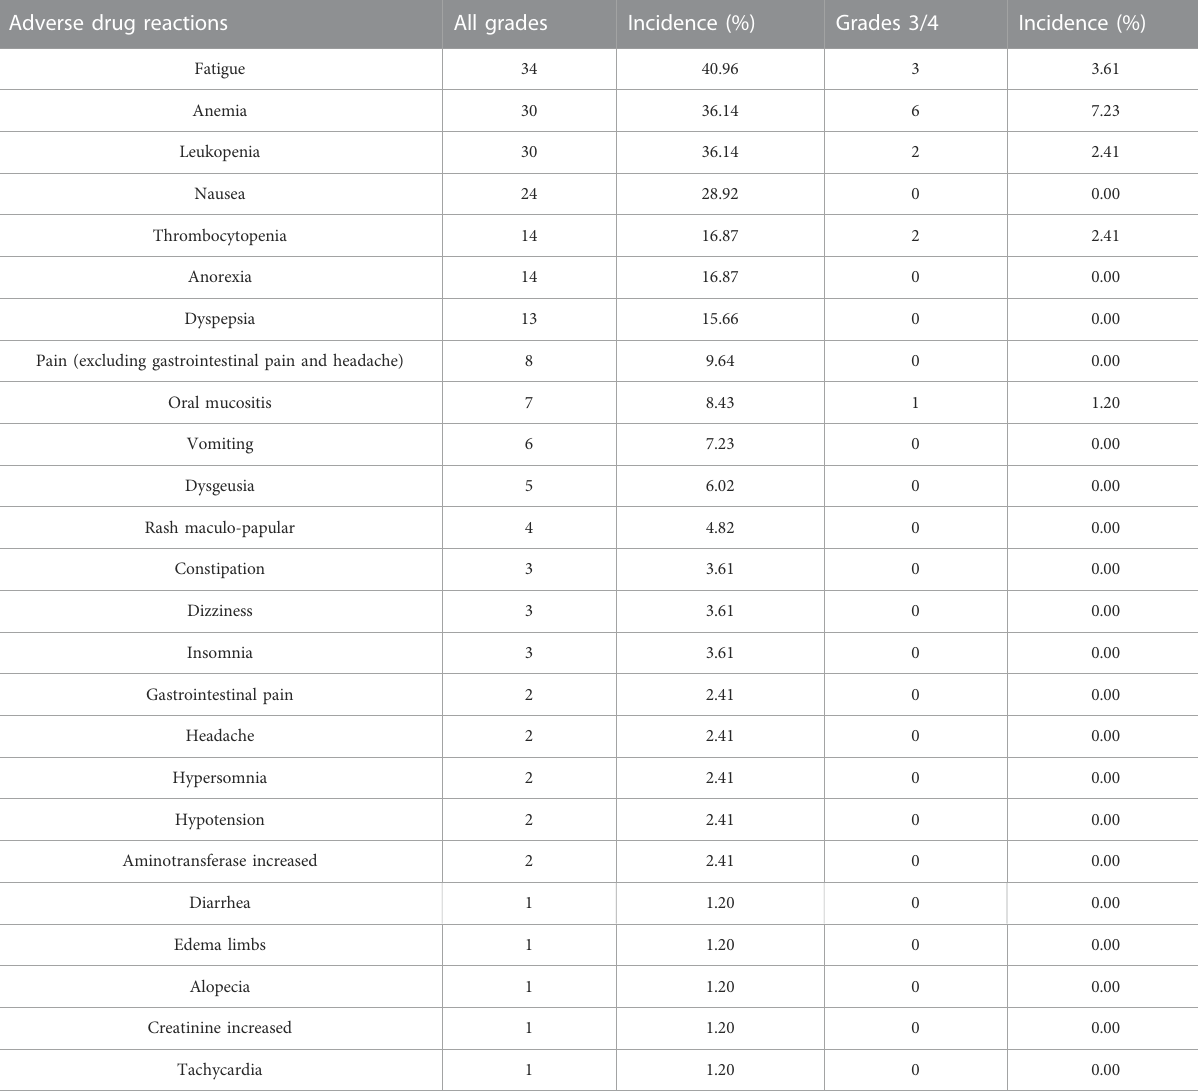
TABLE 2 Incidence of olaparib-induced ADRs. Adverse drug reactions All